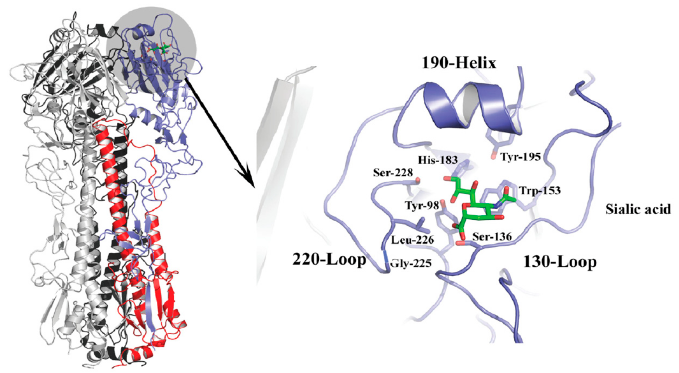
Figure 2. (Left panel) Trimeric HA, with one monomer colored gray, another black, and the third monomer shown in blue (HA1) and red (HA2). The location of the receptor binding pocket for the monomer shown in blue and red is highlighted by the gray circle, and this region is magnified and reoriented in the right panel to depict structural features and conserved residues in the binding pocket, along with the location occupied by bound sialic acid, shown in green. All numbering based on H3 subtype.